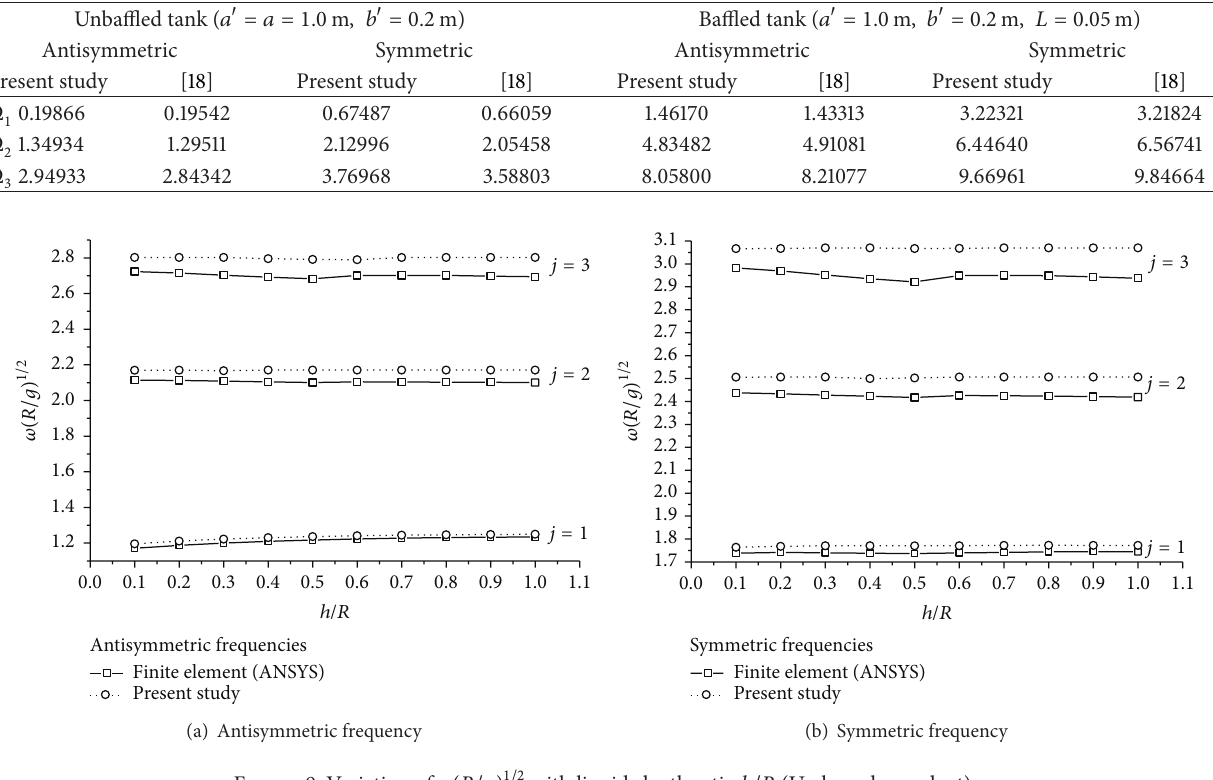
Table 2: The first three normalized antisymmetric and symmetric sloshing frequencies by [18] and present study Ω 𝑗 = √𝑎 󸀠 𝑏 󸀠 𝜔 2 𝑗 /𝑔 , (𝑗 = 1, 2,3) .